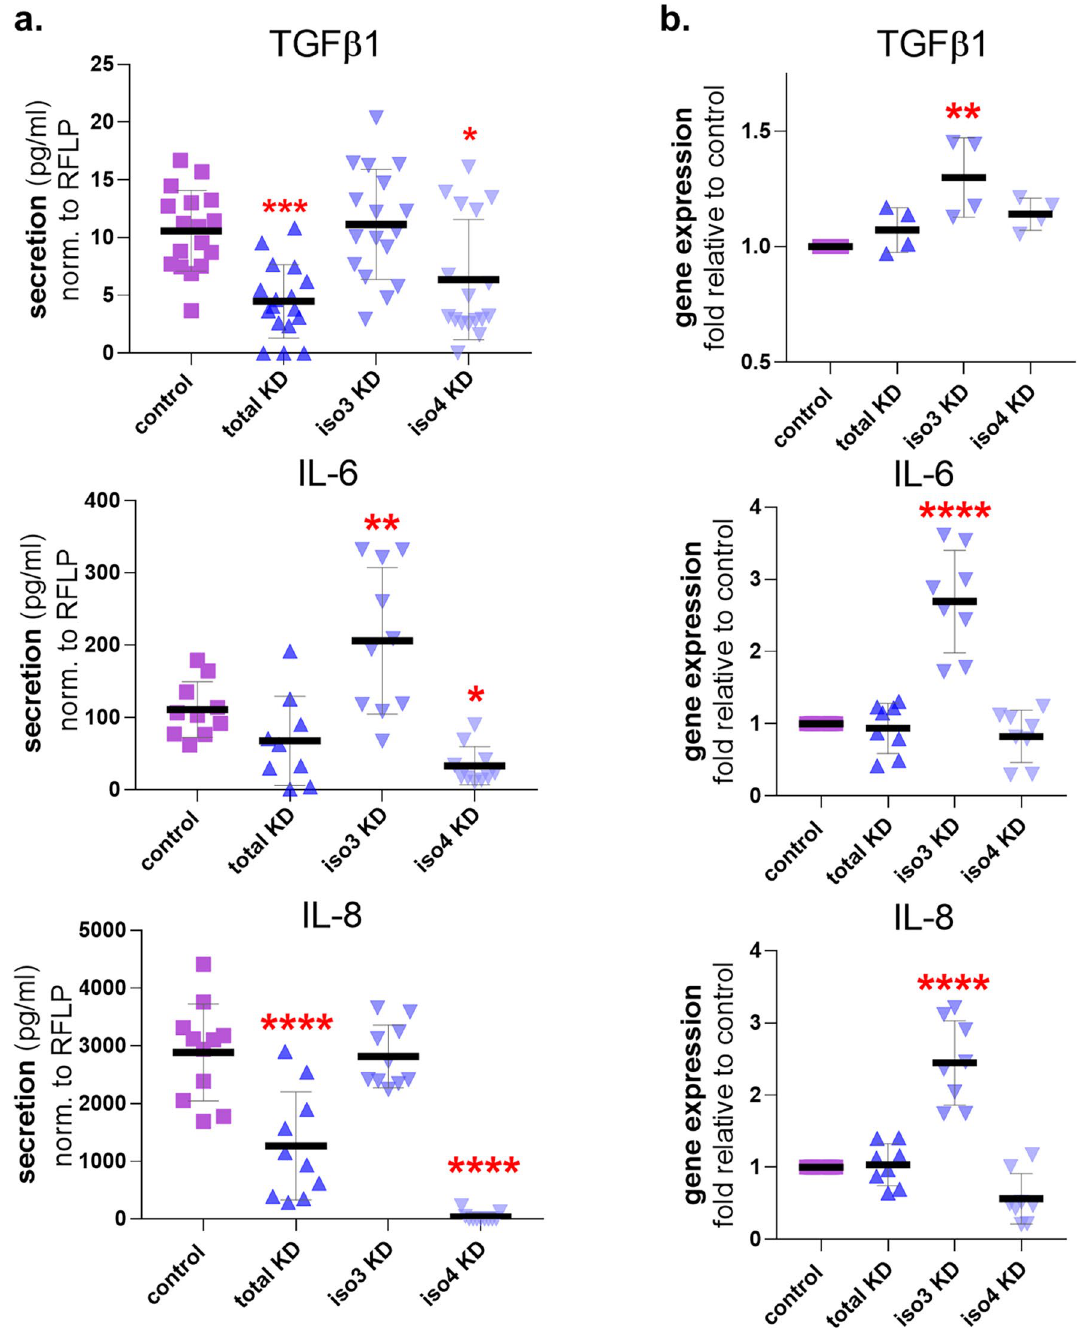
Figure 4. Palladin iso4 is required for CAFs to sustain inflammatory features. ( a ) Measurement of secreted cytokines TGFβ1, IL-6, and IL-8 by palladin KD CAFs normalized to cell number via RFLP expression and compared to control CAF secretions using assorted CAF conditioned media at the end of 5 days ECM production (see “Materials and methods” for additional details). ( b ) Gene expression RT-qPCR transcript analysis of TGFB1 (TGFβ1), IL6 (IL-6), and CXCL8 (IL-8) in palladin KD CAFs, compared to control CAF at the end of 5 days d-ECM production. Data presented were derived from a minimum of 4 experimental replicates of biological duplicates (n = 8). One Way ANOVA, Dunnett’s multiple comparison test was performed to determine statistical significance compared to control CAFs. *p < 0.05; ** p < 0.01; ***p < 0.001; **** p <